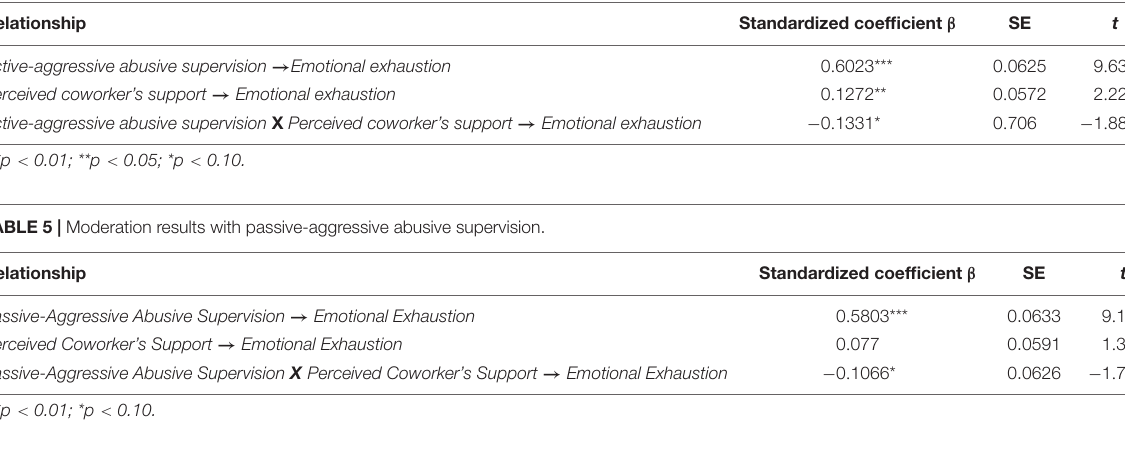
TABLE 4 | Moderation results with active-aggressive abusive supervision.